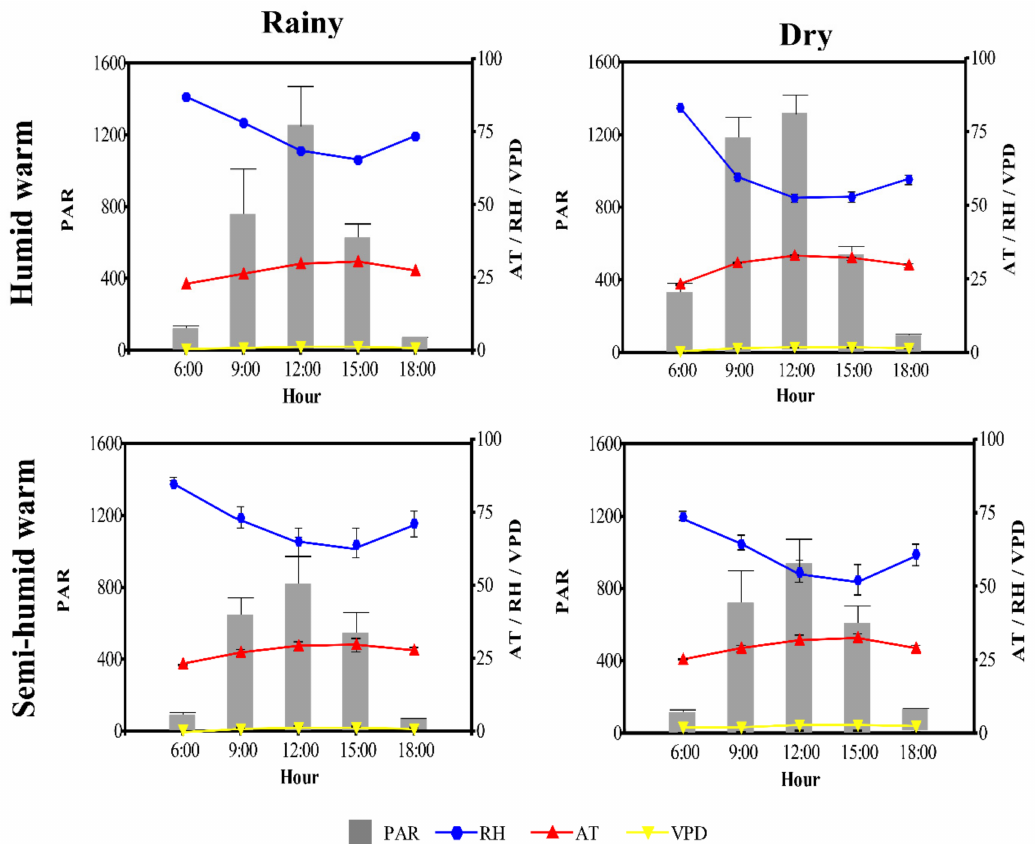
Figure 1. Diurnal microclimatic parameters for two sites with different climates: humid warm (El Paujil) and semi-humid warm (San Vicente del Cagu á n) in Caquet á (Northwestern Colombian Amazon) in two seasonal periods: rainy (April to June 2019) and dry (December 2019 to February 2020). Photosynthetically active radiation ( PAR ), relative humidity ( RH ), air temperature ( AT ) and vapor pressure deficit ( VPD ). The values represent the mean, and the bars the standard error, ( n =